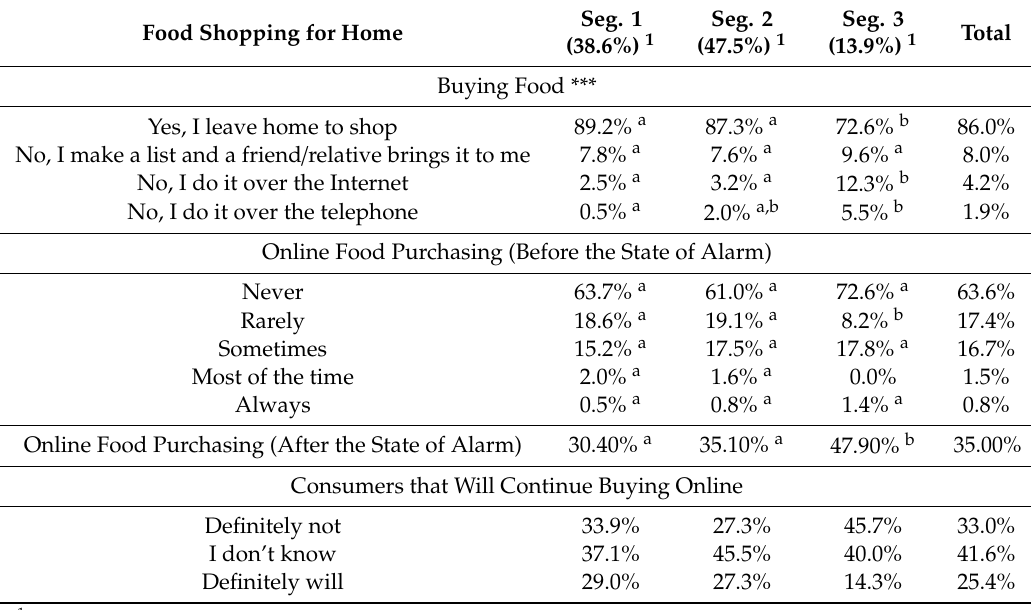
Table 4. Traditional shopping versus online food shopping for